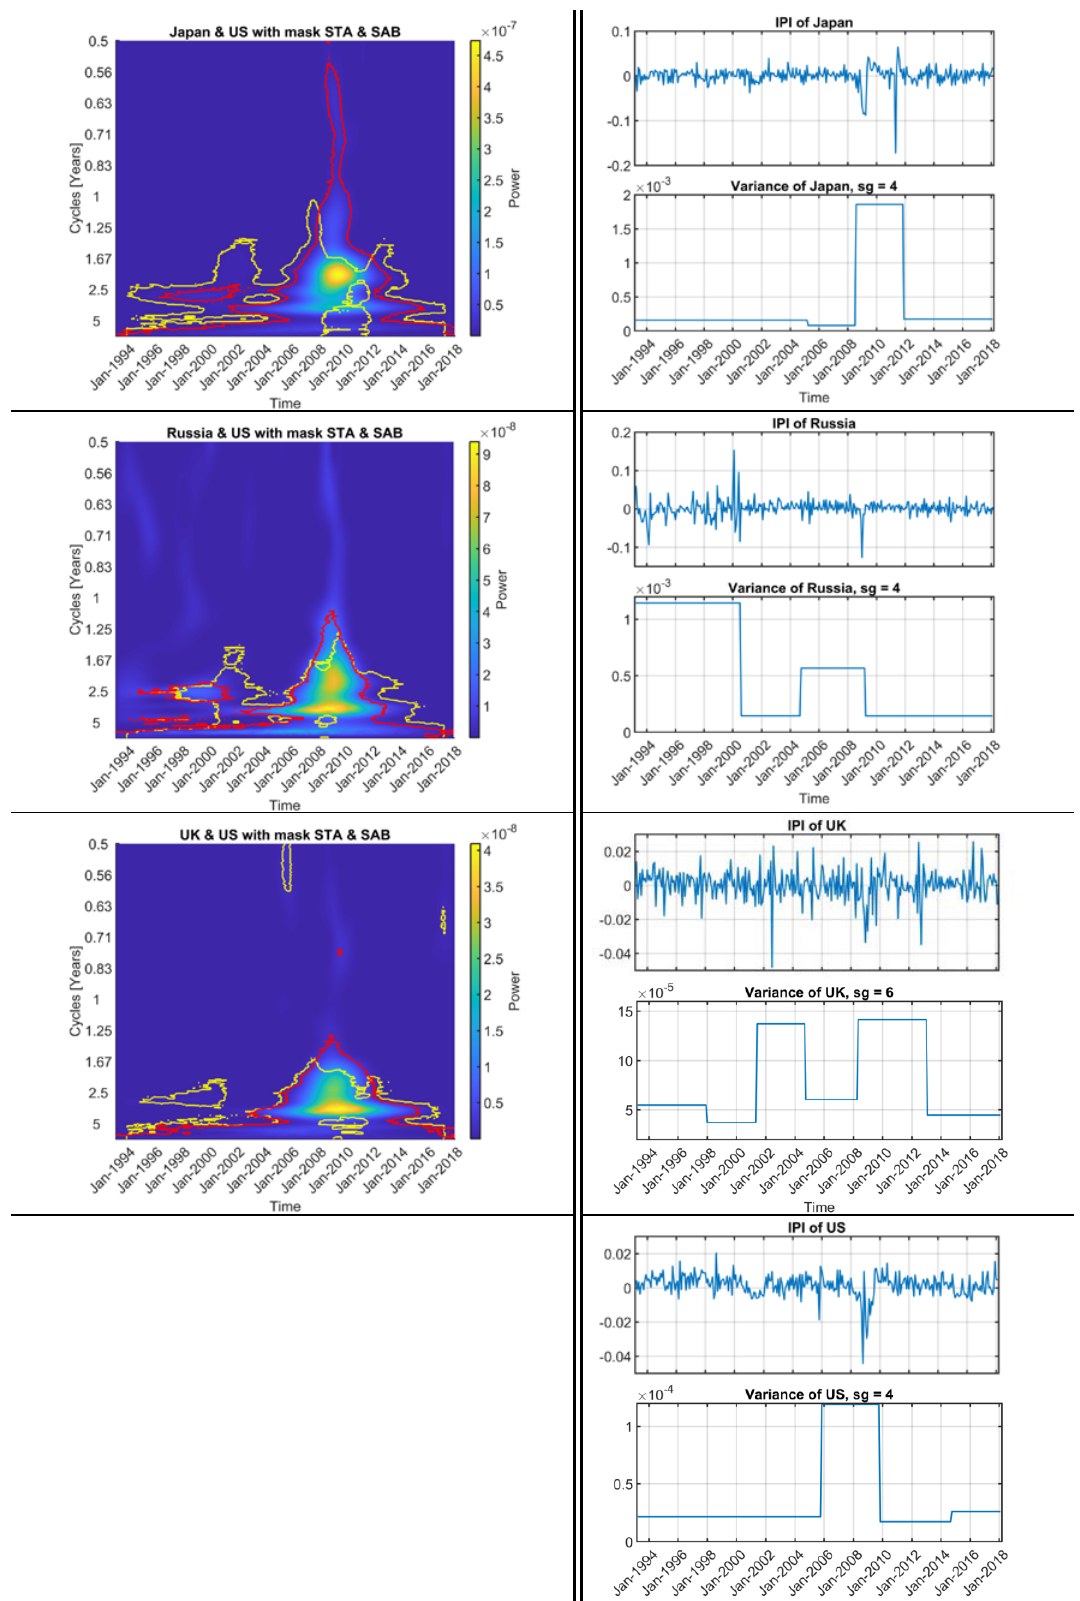
Fig. 1. Co-movement between countries, IPI of each country and variance of their